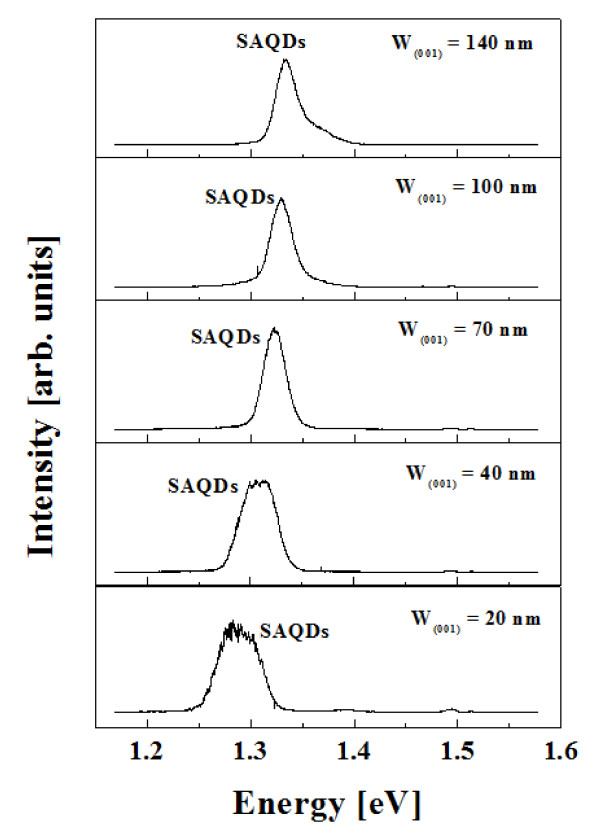
μ-PL spectra at 4.0 K of the In0.8Ga0.2As SAQDs ensemble grown on SiO2-patterned exact (001) GaAs substrates with W(001) of (a) 20, (b) 40, (c) 70, (d) 100, and (e) 140 nm, respectively.